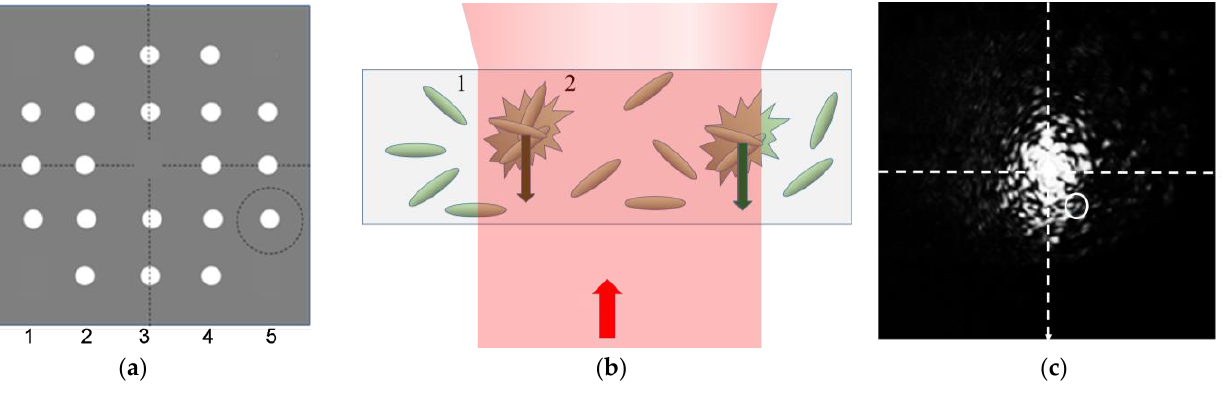
Figure 11. Registration of suspensions of microorganisms in a matrix chip using a 2D collimator ( a ) for the array of 20 measuring cuvettes, an optical scheme of the speckle excitation in microcells ( b ), where 1 – microorganism, 2 – cluster of microorganisms, and the speckle field of the cuvette of the E. coli M-17 filled in phosphate buffer ( c ), where the white circle indicates the signal reception aperture.